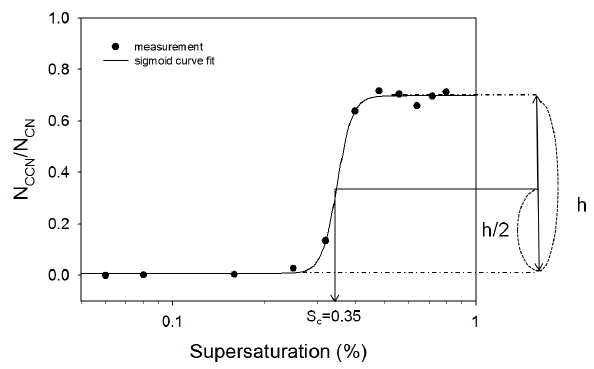
Figure 3. Example of S c characterization for 100 nm dry particles. Fig. 3. Example of S c characterization for 100nm dry particles.